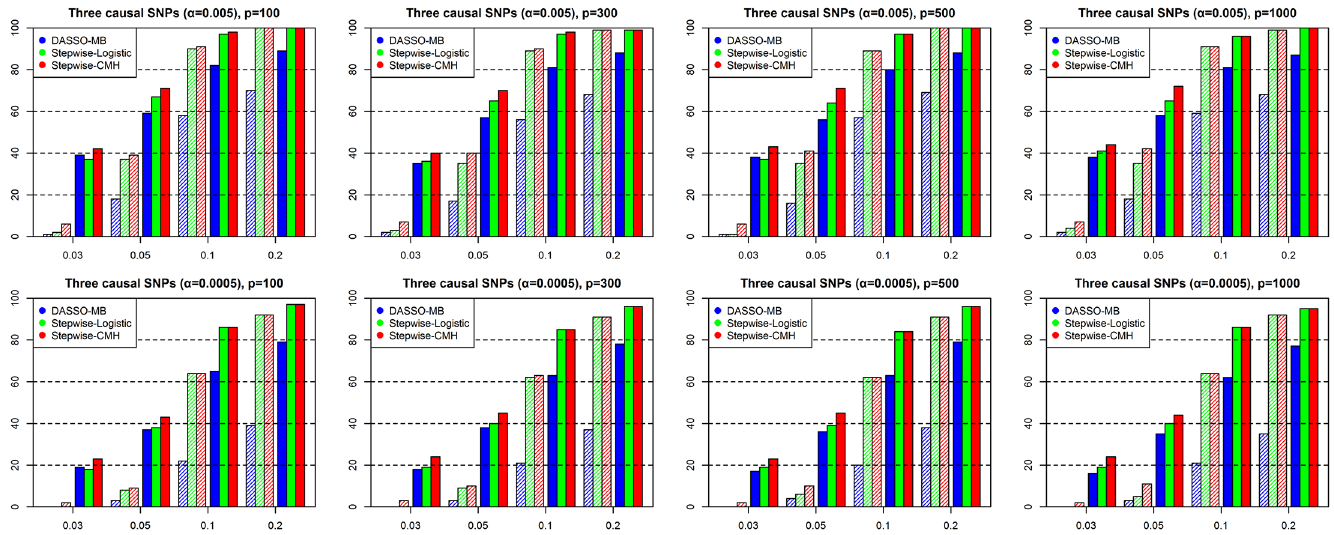
Fig 3. Performance comparison of stepwise CMH method, stepwise logistic and DASSO-MB methods for the codominant model with three causal SNPs.